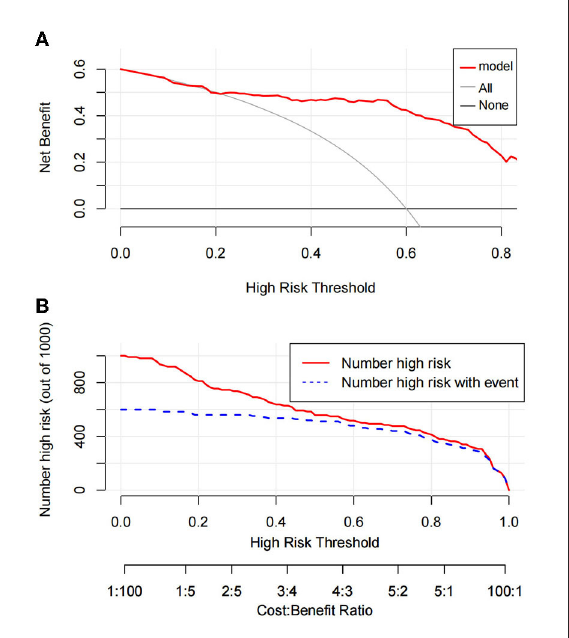
FIGURE5 Decision curve analysis of prediction model (A) . Clinical impact curve of prediction model (B)